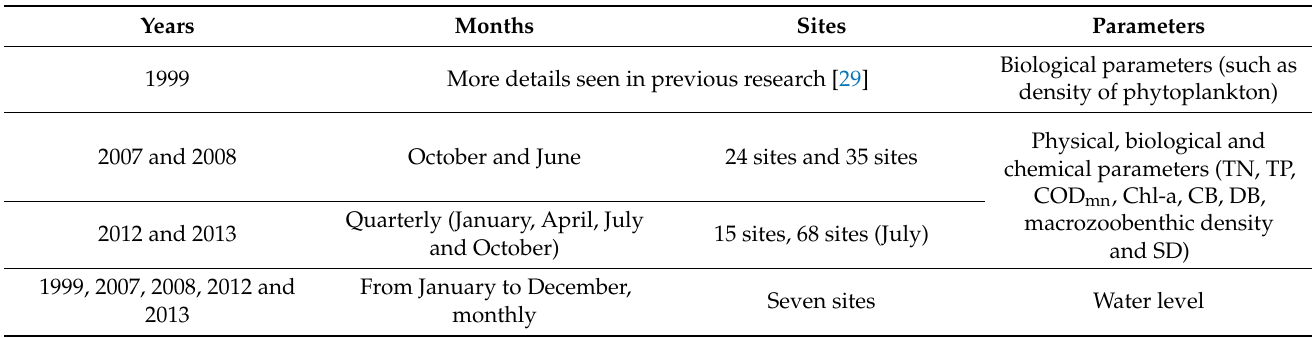
Table 1. Summary of sampled variables and sites quantity in a specified month and year in Poyang Lake. Years Months Sites Parameters Biological parameters (such as 1999 More details seen in previous research [29] density of phytoplankton) Physical, biological and 2007 and 2008 October and June 24 sites and 35 sites chemical parameters (TN, TP, COD mn , Chl-a, CB, DB, Quarterly (January, April, July macrozoobenthic density 15 sites, 68 sites (July) SD)2012 and 2013 and October) and 1999, 2007, 2008, 2012 and From January to December, Seven sites Water 2013 monthly